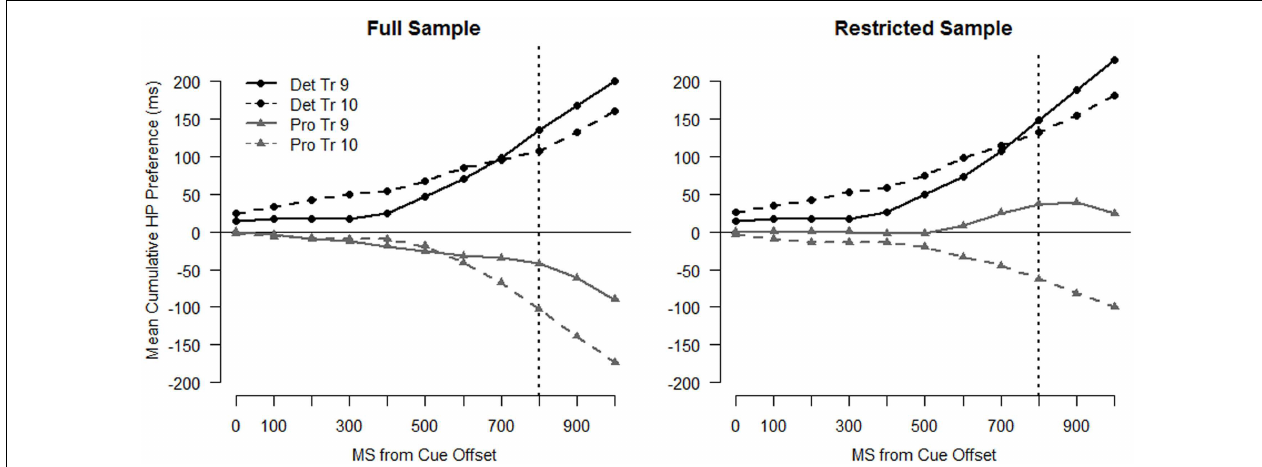
FIGURE 5 | Cumulative preference profiles forTrials 9 and 10. Points above 0 indicate a preference for the HP location and points below 0 indicate a preference for the LP location.The left panel depicts data from the full sample and the right panel depicts data from the restricted sample (see text).The dotted vertical line indicates target